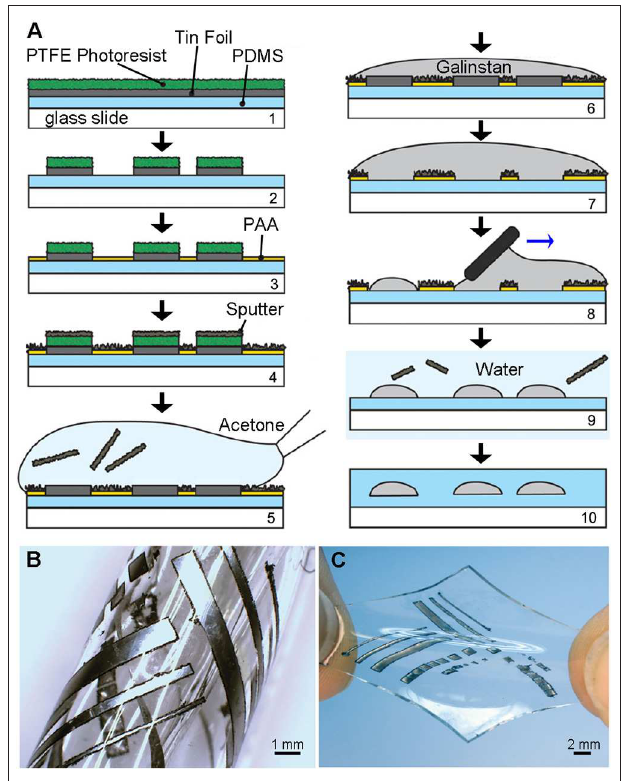
FIGURE 8 | Schematic diagram of liquid-embedded elastomer conductor fabricated by masked deposition of Ga-In alloys (A) , and a liquid-embedded elastomer in bending (B and stretching states (C) , respectively, which is patterned by selectively wetting of Ga-In alloy. Reproduced with permissions from Kramer et al. (2013). Copyright 2013,